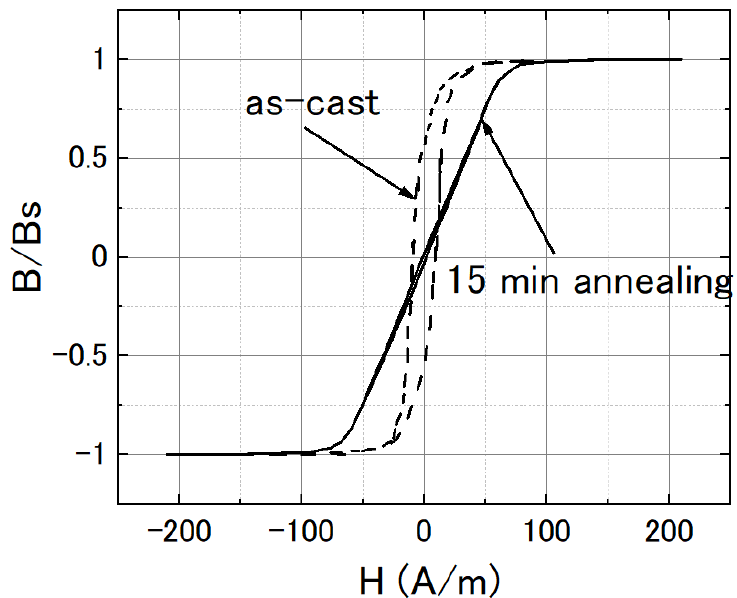
Figure 2. B-H loop of the FeCoSiB amorphous wire in its as-cast form (dashed line) and after 15 min of annealing (solid line).